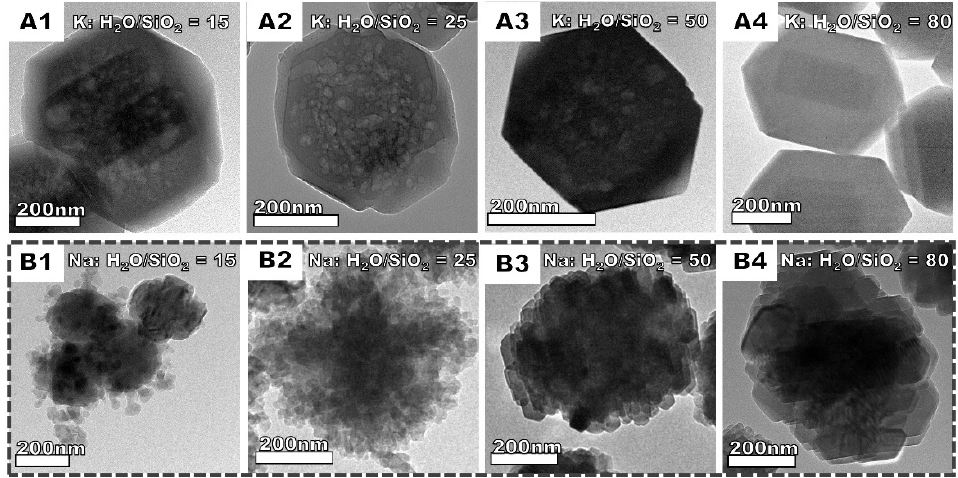
Figure 1. The TEM images of the products synthesized in the K + system with H 2 O/SiO 2 = ( A1 ) 15, ( A2 ) 25, ( A3 ) 50, ( A4 ) 80; and the Na + system with H 2 O/SiO 2 = ( B1 ) 15, ( B2 ) 25, ( B3 ) 50, ( B4 )